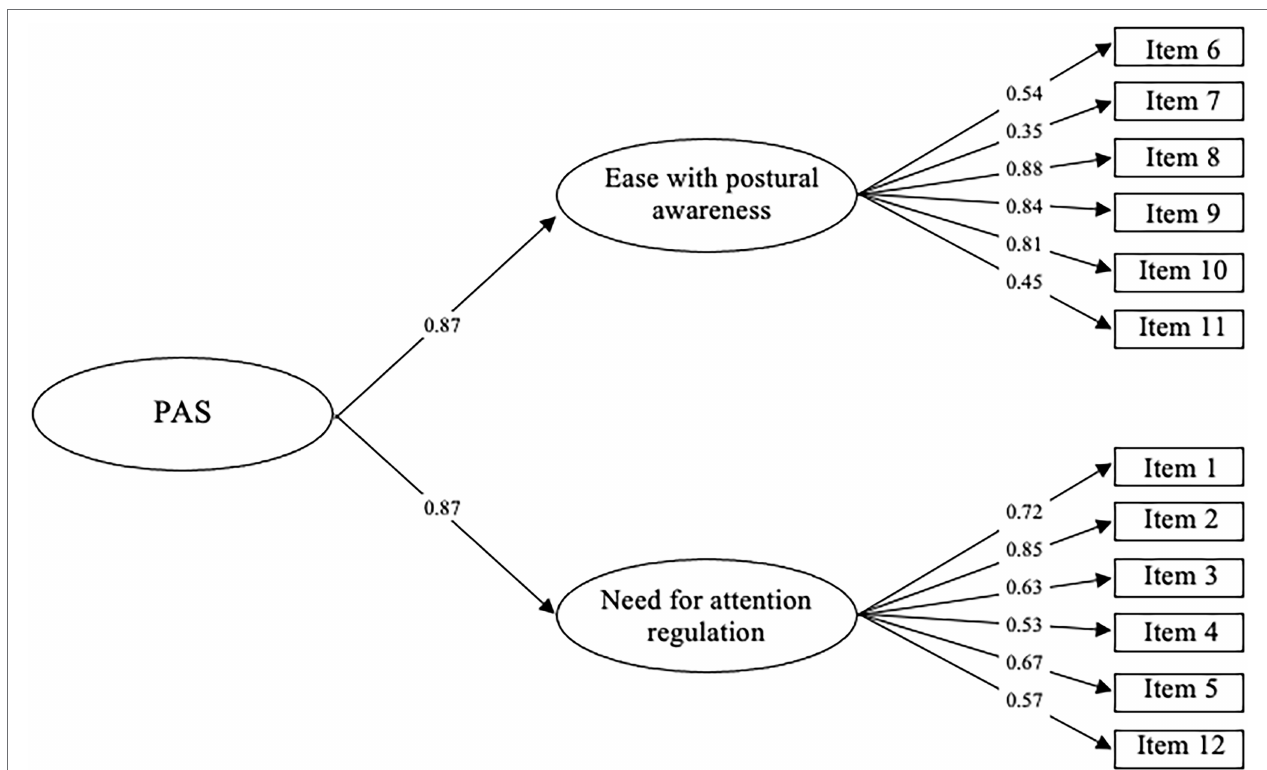
FIGURE 2 | Simplified illustration of the PAS factor model. Values presented represent the standardized regression